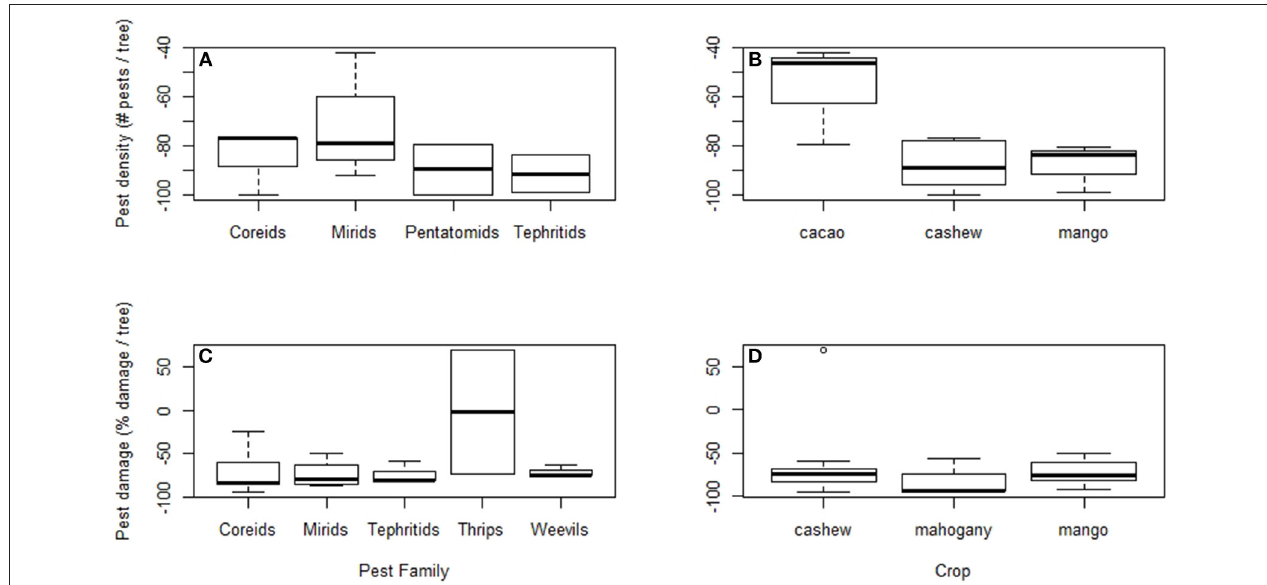
FIGURE 4 | When compared to a control, pest density under ant treatments ( Oecophylla spp.) was significantly lower across pest insect families (A) and crop types (B) . Similarly, pest damage was significantly reduced under ant treatments across pestiferous insect families (C) and three different crops (D) . Reduction in pest damage and density was calculated as a percentage of pest density or damage in ant treatments compared to the control [((Ant-No Ant)/No Ant)*100] ( Peng et al., 1995, 2011, 2012, 2014; Sporleder and Rapp, 1998; Peng and Christian, 2006, 2007, 2008; Ayenor et al., 2007; Van Mele et al., 2007; Adandonon et al., 2009; Dwomoh et al., 2009; Abdulla et al., 2015, 2016, 2017; Anato et al., 2015; Diame et al.,